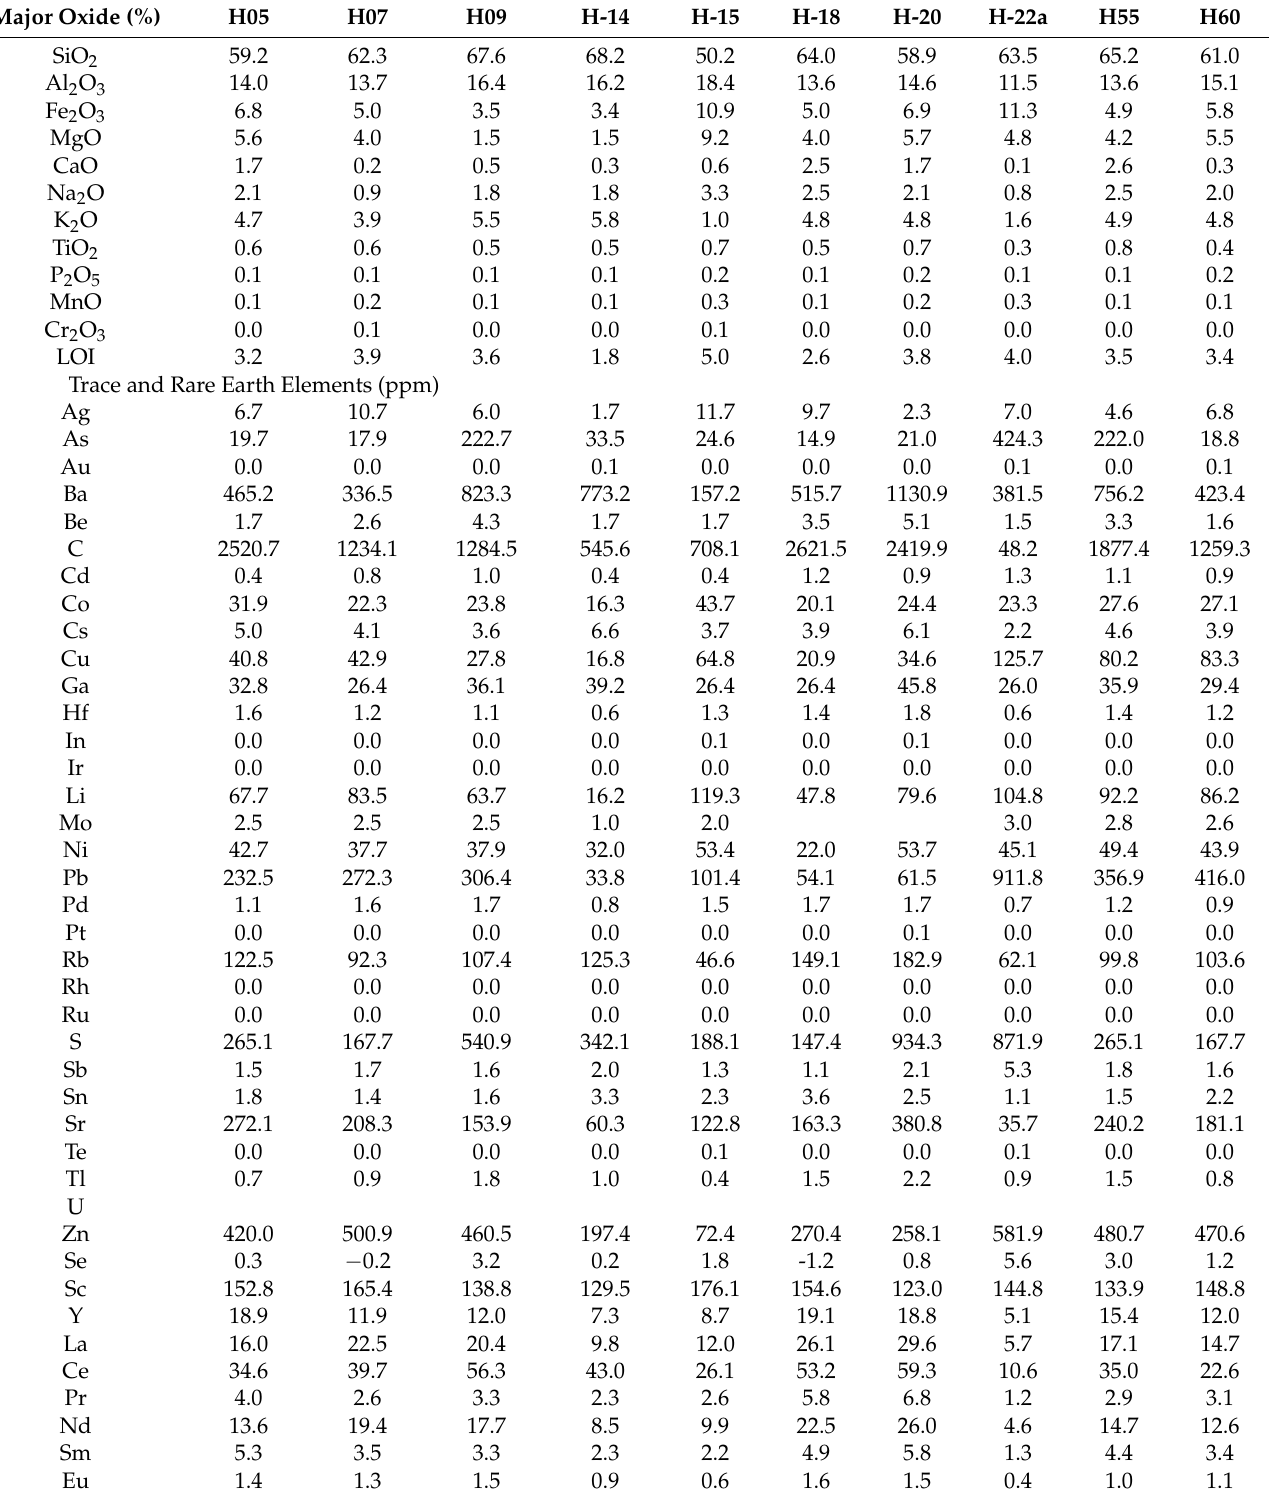
Table 1. The major oxides and trace and rare-earth elements (REE) of metasediments in the Sakarkaya